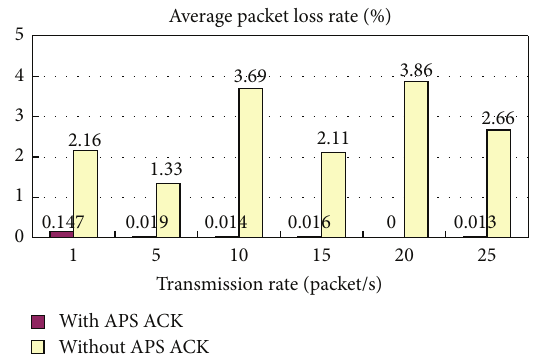
Figure 13: The effect of APS ACK to packet loss rates.